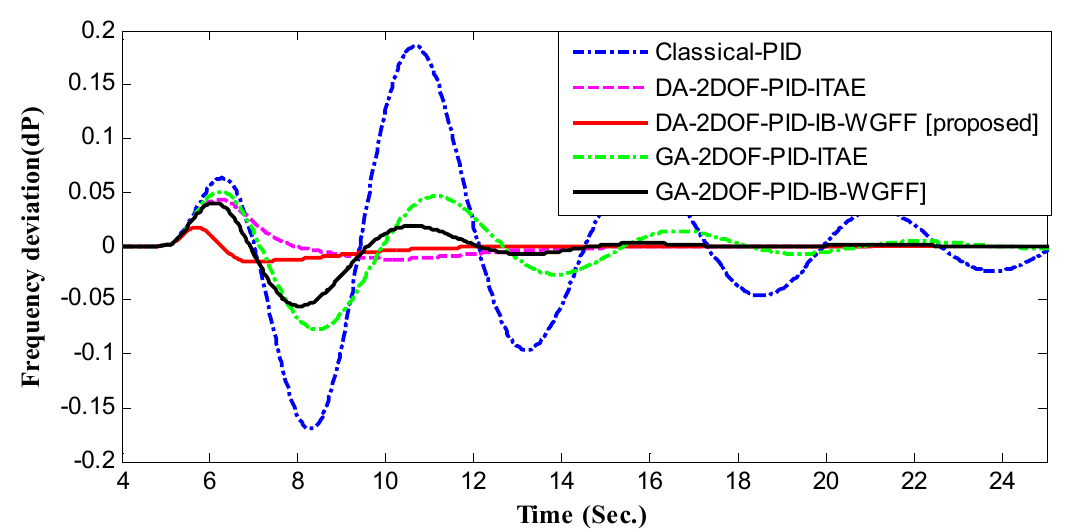
Figure 31. Tie-line power deviation ( Δ P) after implementing parameter perturbations.